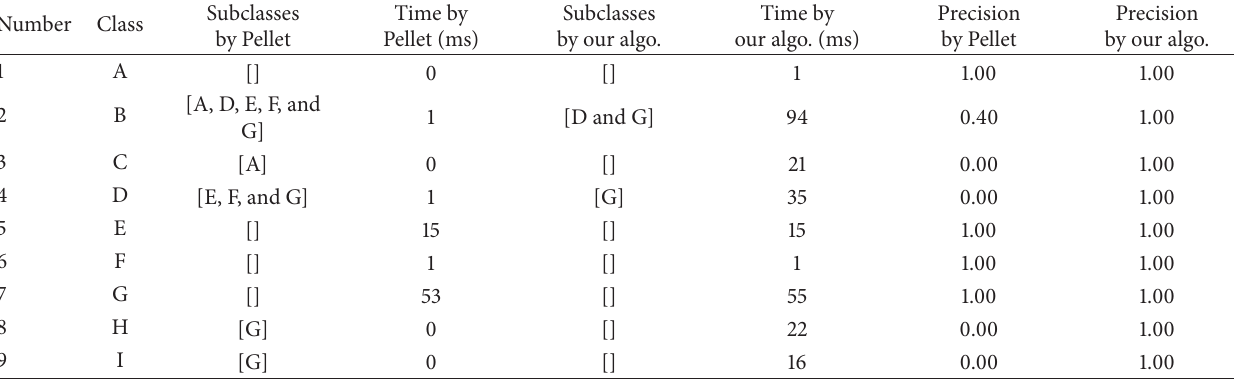
Table 6: Calculating list of subclasses: case 4.